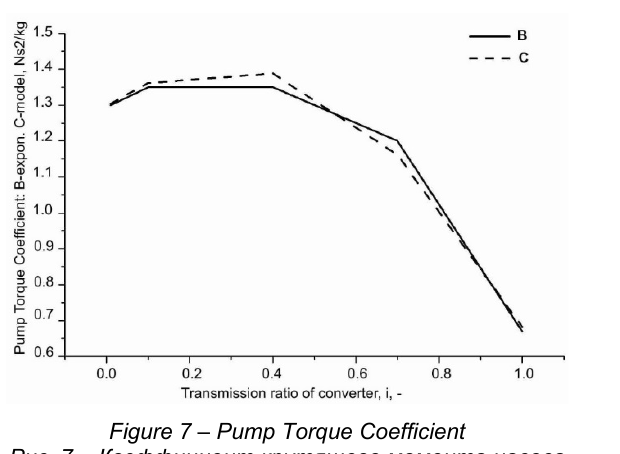
Figure 7 – Pump Torque Coefficient Рис . 7 – Коэффициент крутящего момента насоса Слика 7 – Коефицијент момента пумпног